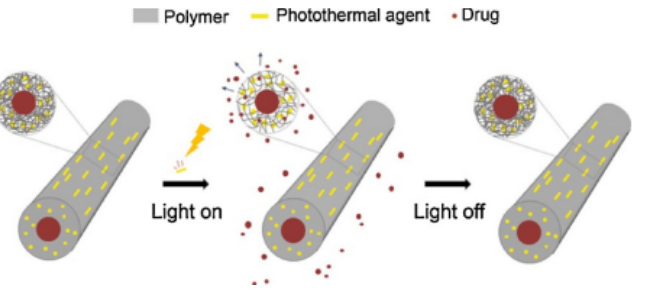
Figure 6. Working principle for a fibrous system capable of NIR light ‐ sensitive, on ‐ demand release of a drug. Reprinted/adapted with permission from Ref. [64]. 2019, Elsevier.